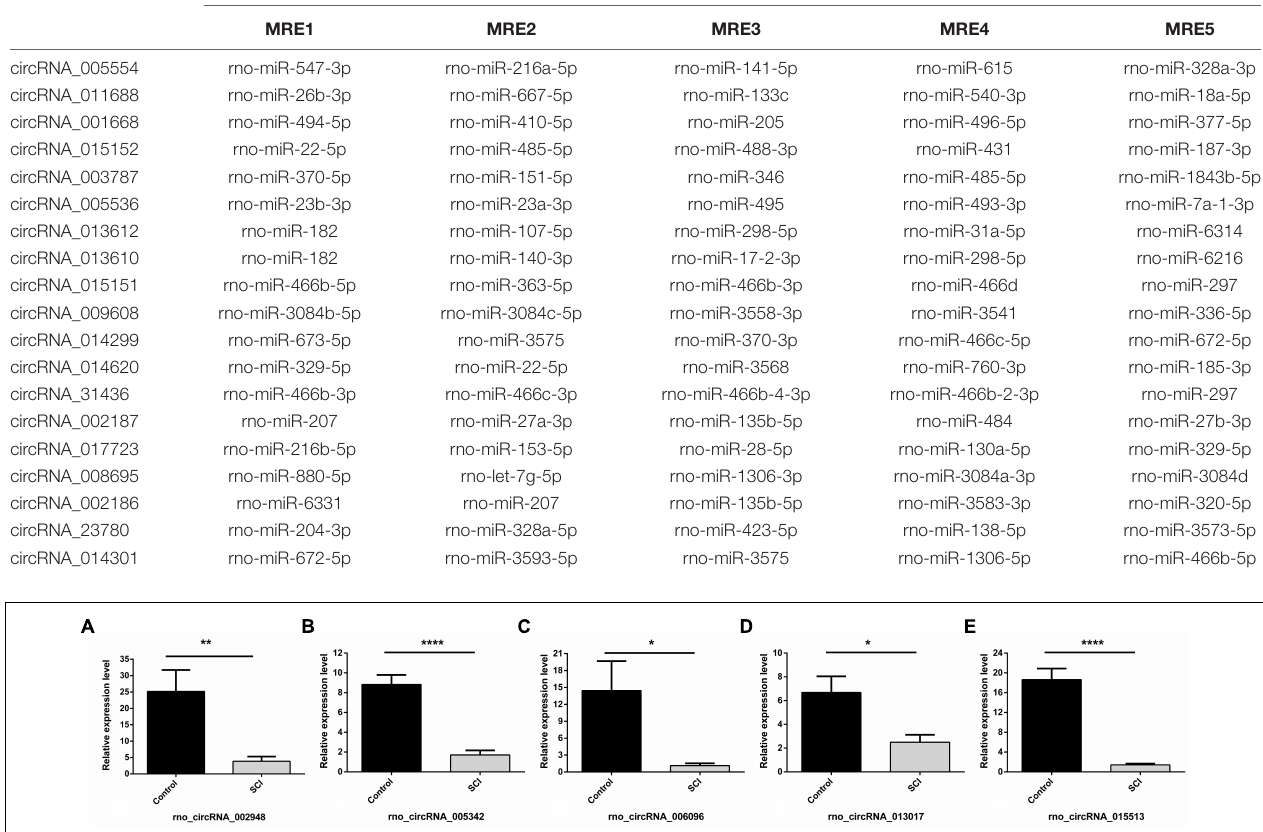
TABLE 2 | The five highest-ranking miRNA candidates for top 10 up-regulated and down-regulated circRNAs. CircRNA Predicted miRNA response elements (MREs) MRE1 MRE2